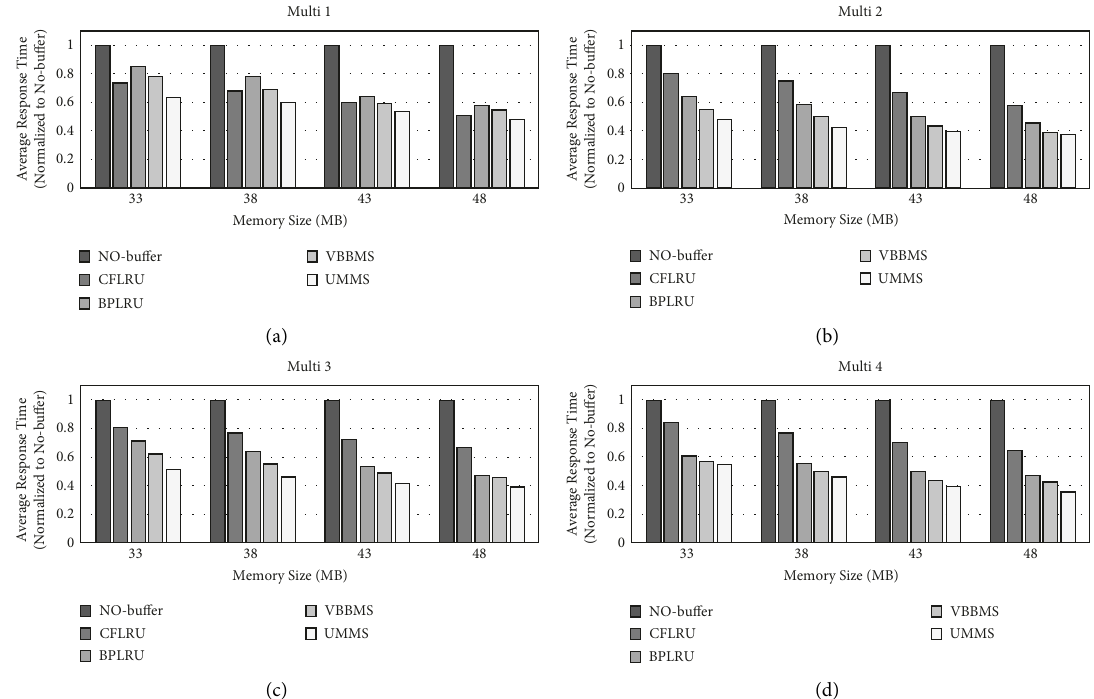
Figure 7: Average response time comparisons. (a) Multi1 workload. (b) Multi2 workload. (c) Multi3 workload. (d) Multi4